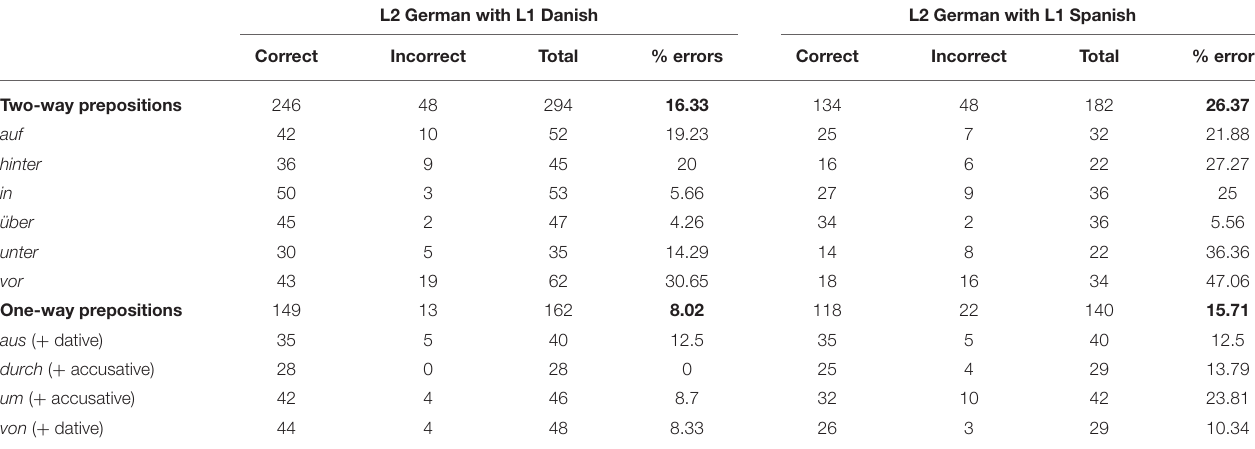
TABLE 1 | Case marking errors by L2 users of German with L1 Danish and L1 Spanish (data set 1, video clip retellings, written data). L2 German with L1 Danish L2 German with L1